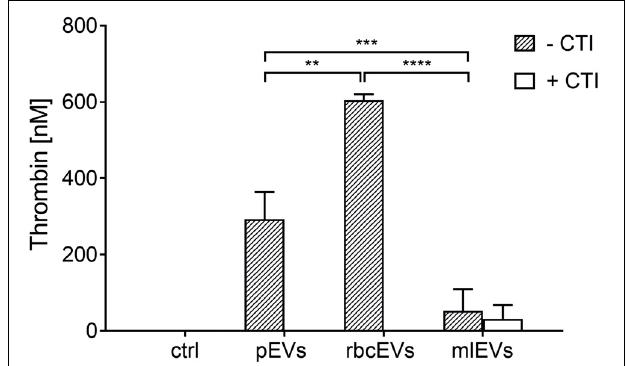
FIGURE 2 | Thrombin generation induced by pEVs, rbcEVs, and mlEVs. EVs were isolated from medical grade platelet concentrates or red blood cell concentrates as well as from monocyte-like cell culture supernatants as described in the section “Materials and Methods.” Aliquots of isolated EVs were normalized regarding their protein content and added to EV-depleted human plasma at a final concentration of 25 µ g/mL, in the presence or absence of corn trypsin inhibitor (CTI; 50 µ g/mL), an inhibitor of contact activation. Thrombin generation was quantified via the cleavage of a fluorogenic substrate ( n = 3); ctrl, plasma incubated with buffer only; ** p ≤ 0.01; *** p ≤ 0.001; **** p ≤